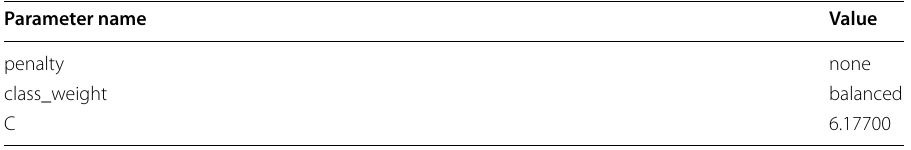
Table 81 Modes of LR tuned hyperparameter values for experiments with the data exfiltration dataset